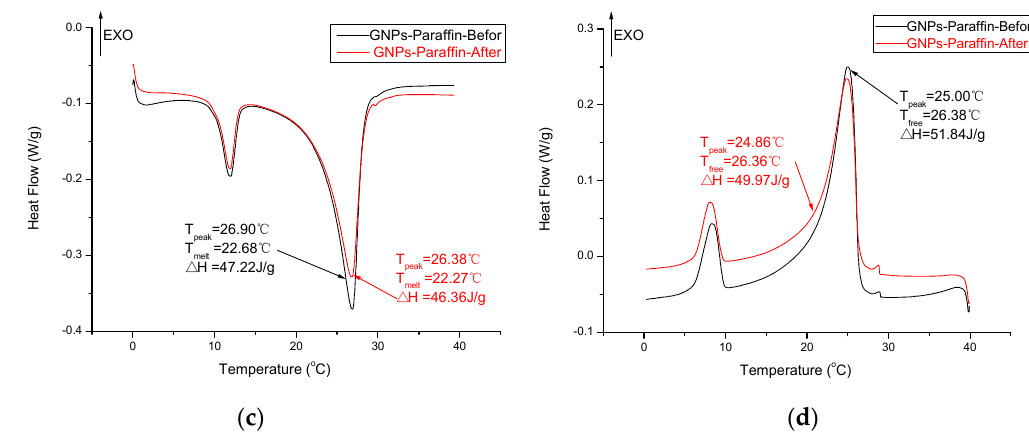
Figure 10. DSC thermograms of composite PCM before and after 100 thermal cycles. ( a ) endothermic curve of EG-paraffin; ( b ) exothermal curve of EG-paraffin; ( c ) endothermic curve of GNPs-paraffin; ( d ) exothermal curve of GNPs-paraffin.